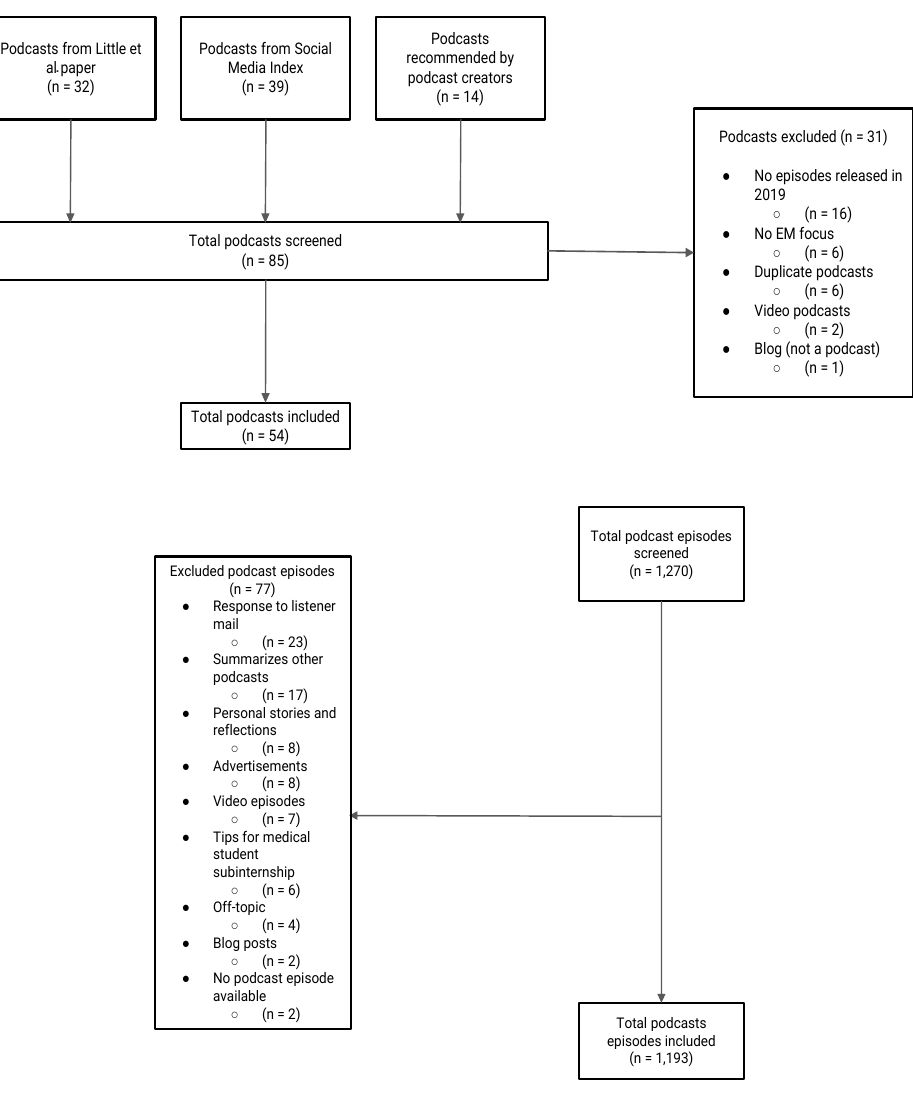
Figure 1. Podcast